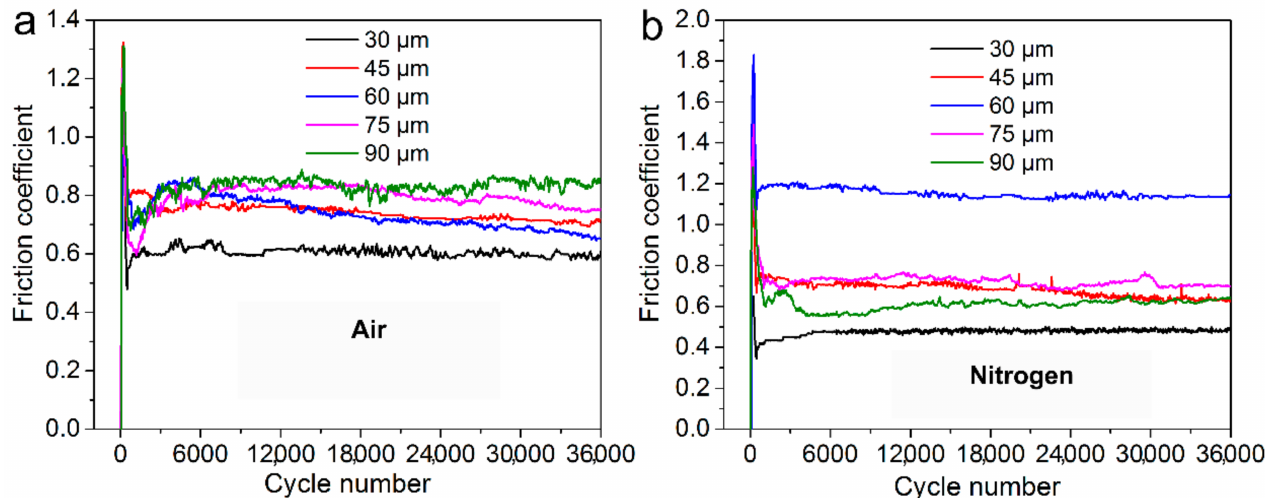
Figure 1. Friction coefficient of alloy 690 during fretting wear at different displacement amplitudes in ( a ) air and ( b )